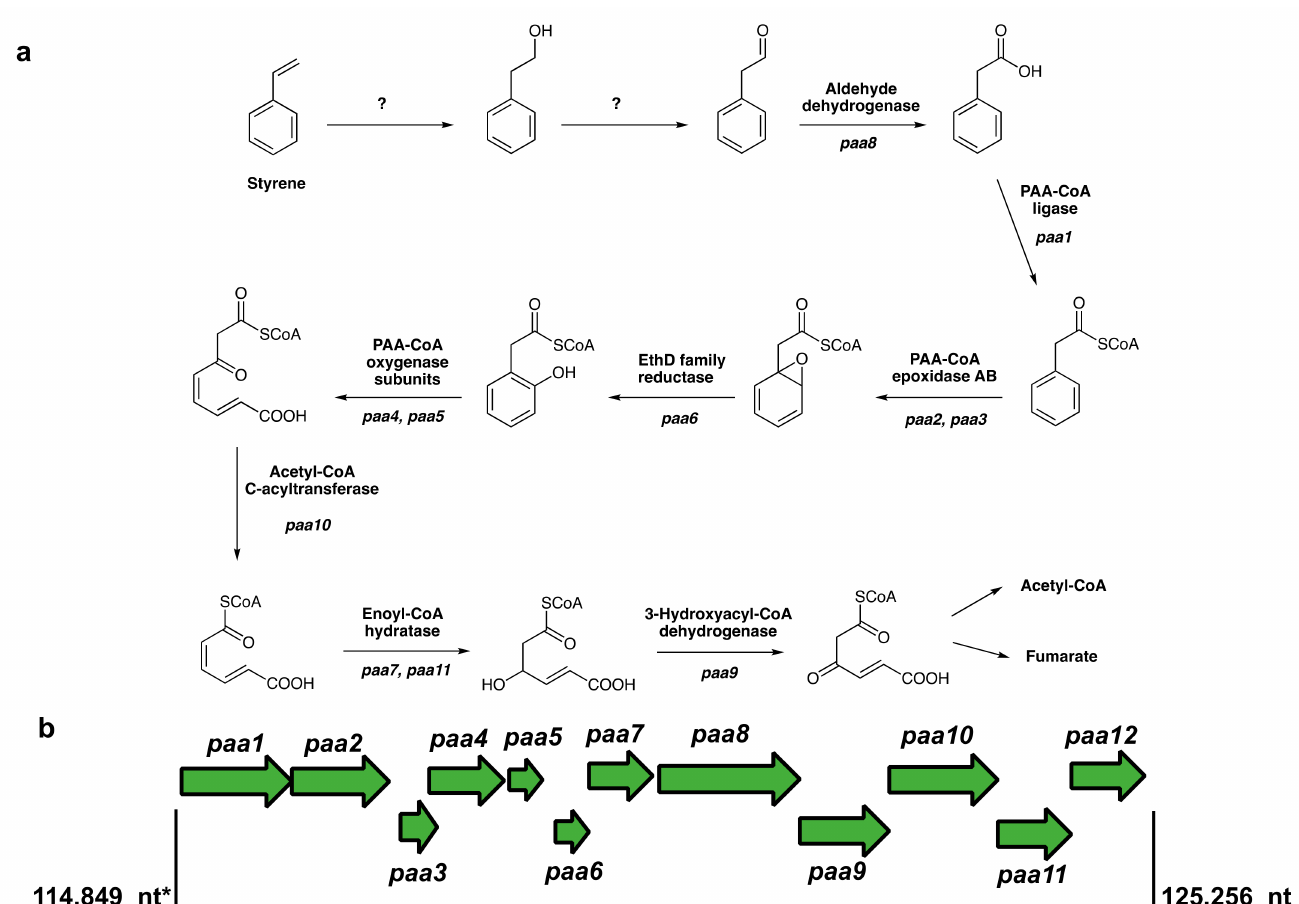
Figure 7. Genome-based pathway prediction for PS degradation in Exiguobacterium sp. RIT 594. ( a ) PS is presumably depolymerized to styrene and then metabolized via phenylacetic acid (PAA). The initial steps are unknown (question marks) and the genes corresponding to the enzyme activ- ities predicted from the genome annotations are shown in bold italics. ( b ) The paa gene cluster showing the arrangement of genes and the location in the genome (114,849–125,256 nt). * = alter- nate start at 114,872 nt. paa1 = phenylacetate-CoA ligase, paa2 = 1,2-phenylacetyl-CoA epoxidase subunit A, paa3 = 1,2-phenylacetyl-CoA epoxidase subunit B (paaH), paa4 = phenylacetate-CoA oxy- genase subunit (paaI), paa5 = phenylacetate-CoA oxygenase subunit (paaJ), paa6 = EthD family reductase, paa7 = enoyl-CoA hydratase, paa8 = aldehyde dehydrogenase, paa9 = 3-hydroxyacyl- CoA dehydrogenase, paa10 = acetyl-CoA C-acyltransferase, paa11 = enoyl-CoA hydratase, and paa12 = paa degradation operon negative regulatory protein (paaX). The thioesterase is located sep- arately at 114,128–114,523 nt. The gene names in parentheses indicate the nomenclature used for E. coli K12. The enzymes for styrene epoxide/phenylethanol generation and oxidation to phenylac- etaldehyde are missing (indicated by